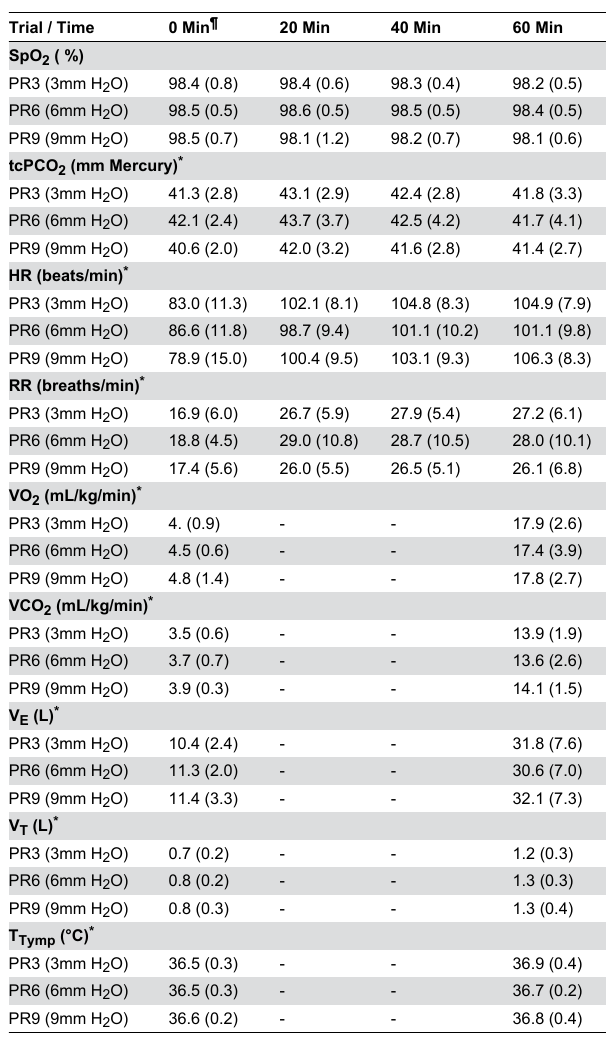
SpO 2 (pulse oximetry-derived oxygen saturation; tcPCO 2 (partial pressure of transcutaneous carbon dioxide); HR (heart rate); RR (respiratory rate); VO 2 (volume of oxygen utilization); VCO 2 (volume of carbon dioxide production); V E (minute ventilation); V T (tidal volume); T Tymp (tympanic temperature). * significant time effect. ¶ indicates the point at which the PR was donned doi: